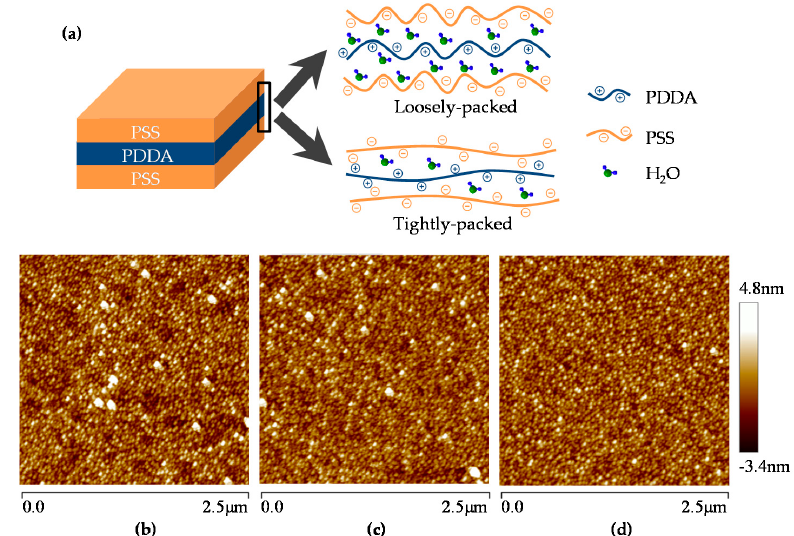
Figure 5. Comparison of loosely-packed and tightly-packed nanostructure of PET thin films. ( a ) Schematic illustration of the loosely-packed and tightly-packed nanostructure of poly(sodium 4-styrenesulfonate)/poly(diallyldimethytlammonium choride) (PSS/PDDA) bilayers; ( b ) atomic-force microscopy (AFM) height image showing the morphology of PSS/PDDA bilayers assembled via dipping-assisted method in 20 mg/mL solutions. The root-mean-square roughness is 1.09 nm ± 0.06 nm; ( c ) AFM height image showing the morphology of PSS/PDDA bilayers assembled via dipping-assisted method in 0.2 mg/mL solutions. The root-mean-square roughness is 0.95 nm ± 0.03 nm; ( d ) AFM height image showing the morphology of PSS/PDDA bilayers assembled via spinning-assisted method in 20 mg/mL solutions. The root-mean-square roughness is 0.90 nm ± 0.03 nm. The root-mean-square roughness was obtained from three different scanning areas for each sample.